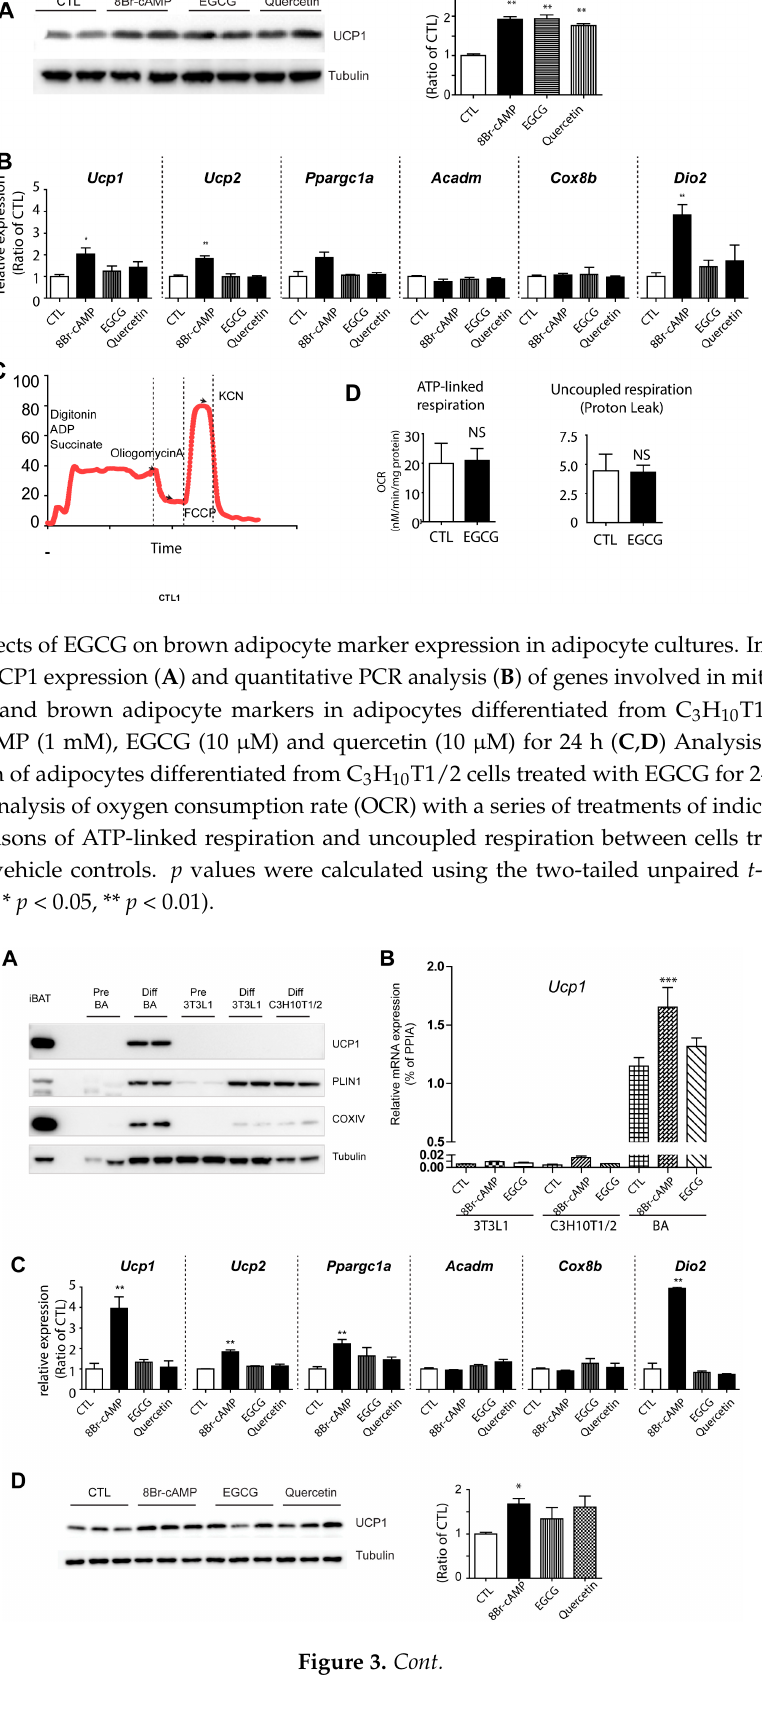
6 of 13 Figure 1. Effects of EGCG on lipid content and PKA signaling in adipocytes ( A – C ) BODIPY staining ( A ), intracellular triglyceride levels ( B ), dimeters of lipid droplets ( C ) in adipocyte differentiated from C 3 H 10 T1/2 cells treated with starvation medium, 8Br-cAMP (1 mM) and EGCG (10 μ M) for 24 h ( D , E ) Immunoblot analysis of p-HSL, HSL, p-CREB, and CREB in adipocyte differentiated from C 3 H 10 T1/2 cells treated with starvation medium, 8Br-cAMP (1 mM) and EGCG (10 μ M) for 24 h. p values were calculated using the two-tailed unpaired t -test ( n = 3, means ± SE; * p < 0.05, ** p < 0.01, *** p < 0.001). 3.2. Effects of EGCG on Browning of Adipocytes